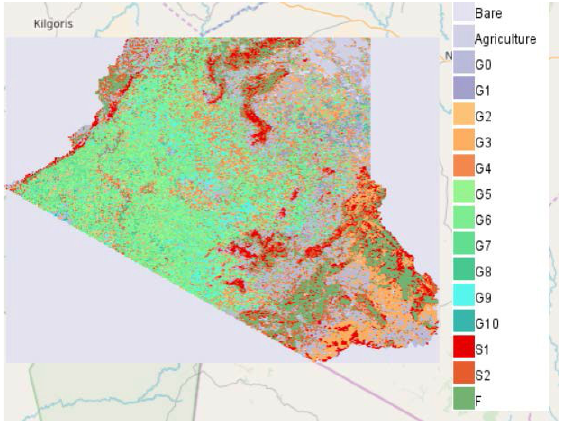
Figure 3. The structural vegetation cover map with the different floristic grass compositions per cover type.